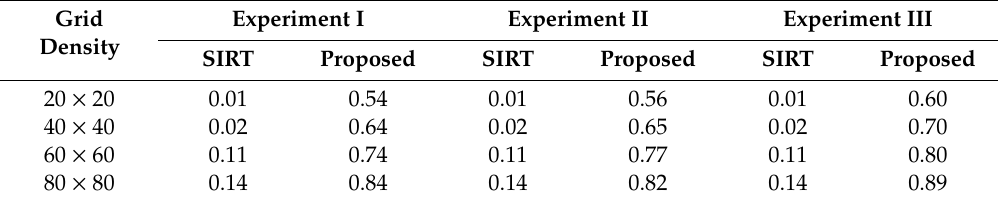
Table 3. The computation time of the SIRT and our method (unit: s).